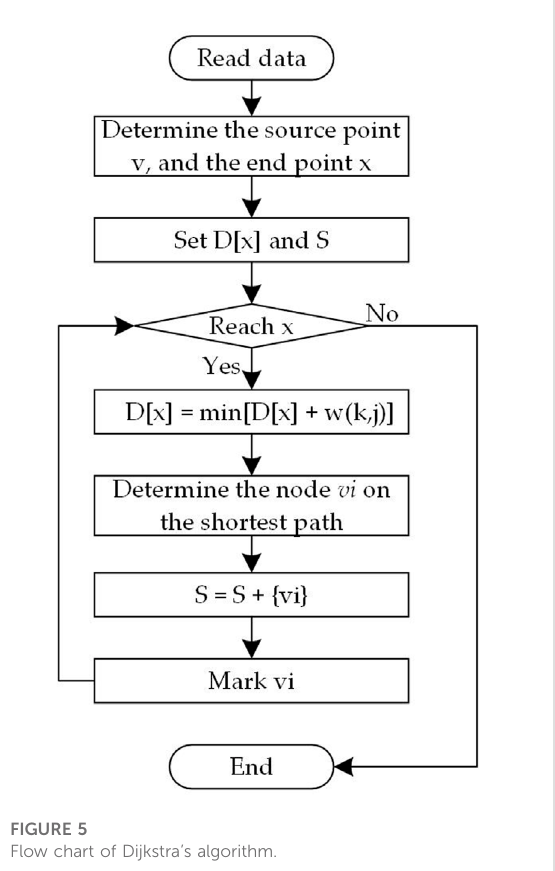
FIGURE 5 Flow chart of Dijkstra ’ s